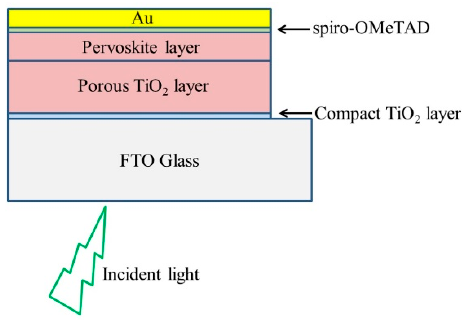
Figure 1. Device configuration of the perovskite solar cell.